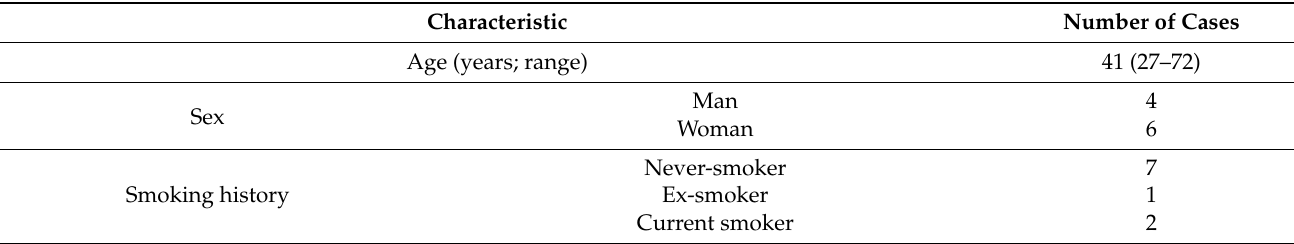
Table 1. Clinical characteristics of our 10 PPHL